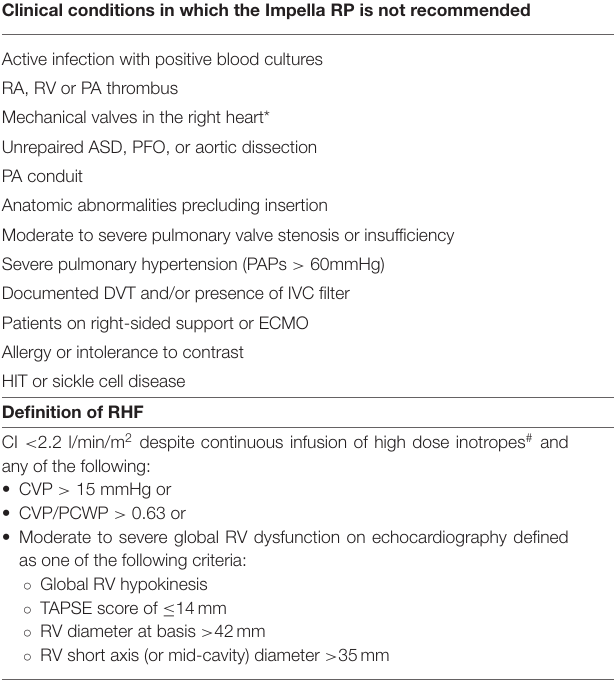
Table adapted from Abiomed ® recommendations for Impella RP patient selection. * Presence of a tricuspid ring or bio-prosthesis is not a contra-indication, but it may result in a difficult implantation depending on the valve strut orientation within the RVOT. # Dobutamineof ≥ 10 µ g/kg/minorequivalentformorethan15min(120minformilrinone) and/or administration of more than one inotrope/vasopressor. ASD, Atrial septal defect; CVP, Central venous pressure; PCWP, Pulmonary capillary wedge pressure; DVT, Deep vein thrombosis; HIT, Heparin induced thrombocytopenia; PA,Pulmonaryartery;PAPs,Pulmonaryarterysystolicpressure;PFO,Persistentforamen ovale; RA, Right atrium; RV, Right